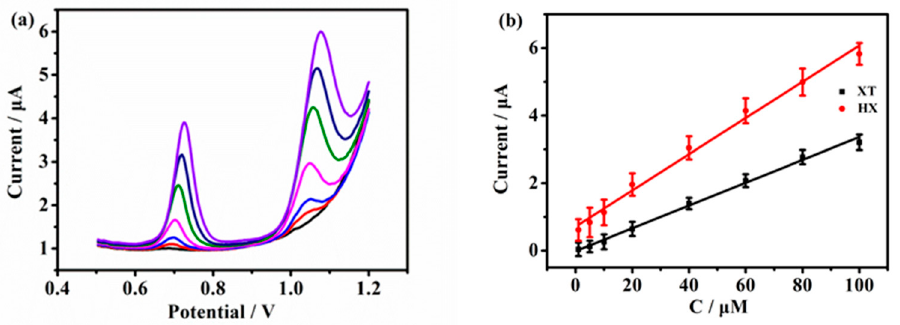
Figure 7. ( a ) DPVs of the p-Gly/rGO/GCE to simultaneously determine XT and HX in 0.1 M PBS (pH 6.0). ( b ) The corresponding calibration plots.